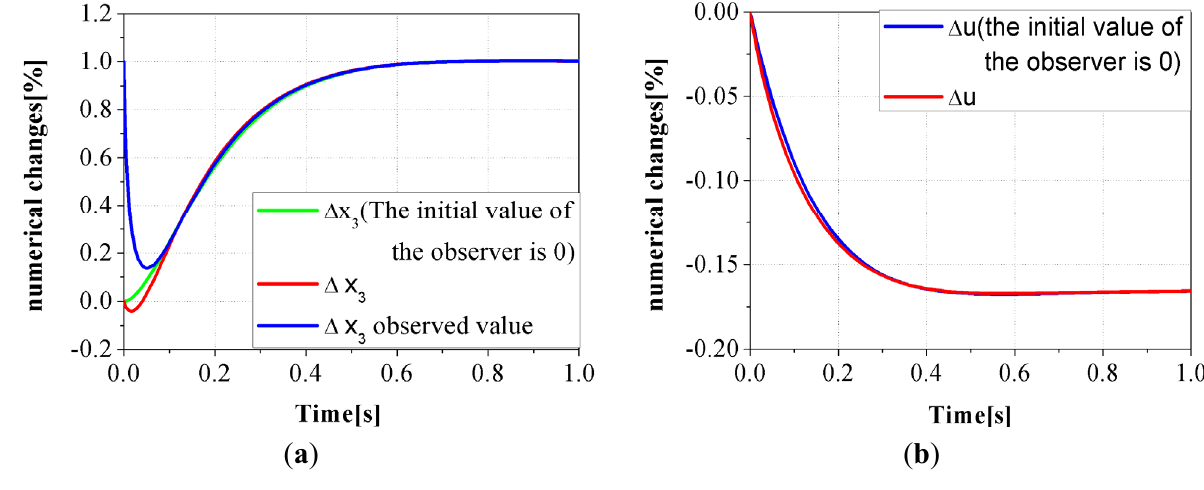
Figure 7. Step response of the compound system. ( a ) numerical changes of Δ x 3 ; ( b ) numerical changes of Δ u